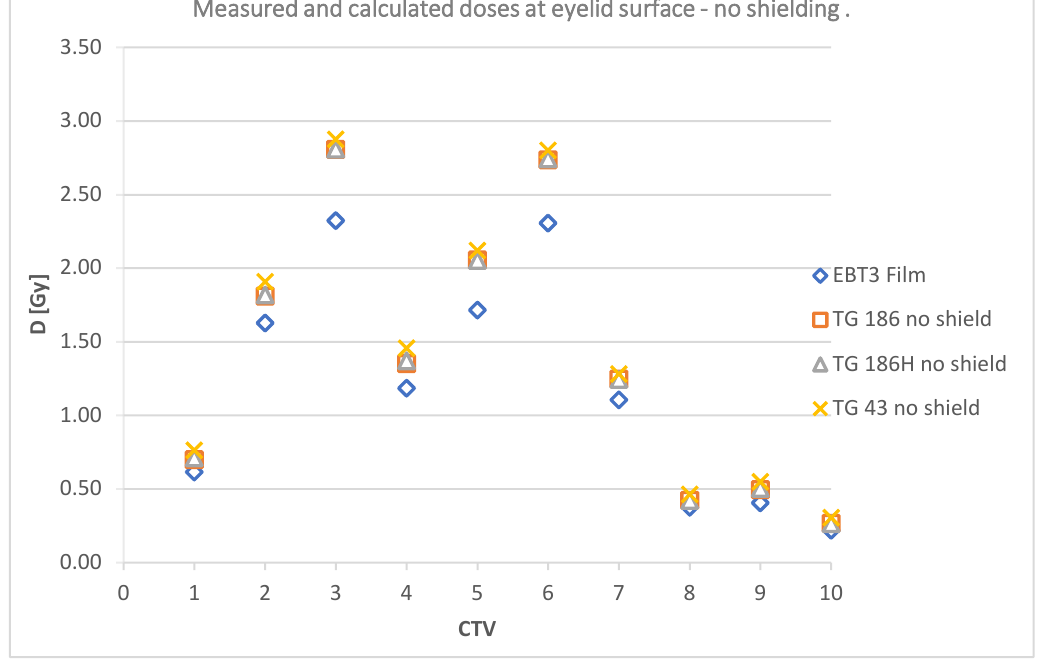
Figure 12. Deposited doses measured at a point on the surface of the eyelid without a shielding.